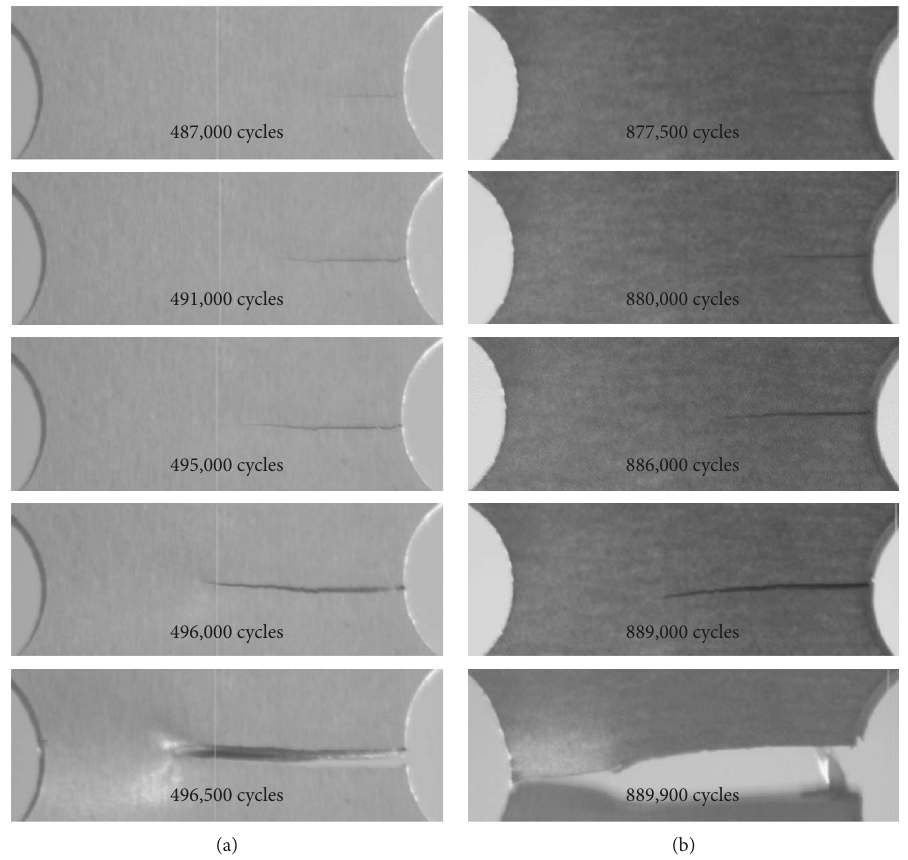
Figure 12: Fatigue crack growth evolution in notched samples: (a) AR; (b) LSP.